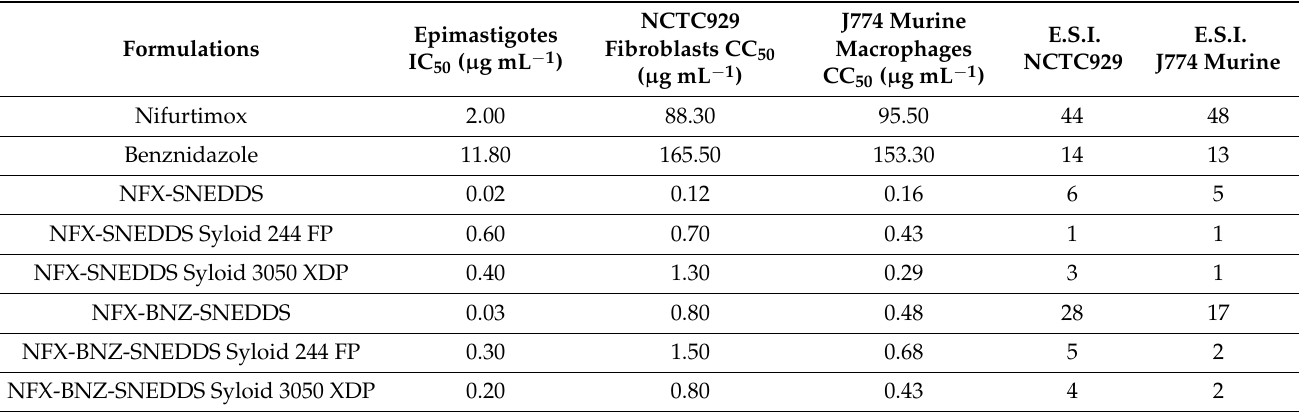
Figure 7. Shelf-life prediction in years of formulations under refrigerated conditions. NFX-SNEDDS ( A ), NFX-SNEDDS impregnated on Syloid 244 FP (2:1 w / w ) ( B ), NFX-SNEDDS impregnated on Syloid 3050 XDP (2:1 w / w ) ( C ), NFX -BNZ SNEDDS ( D ), NFX -BNZ-SNEDDS impregnated on Syloid 244 FP (2:1 w / w ) ( E ), NFX -BNZ-SNEDDS impregnated on Syloid 3050 XDP (2:1 w / w ) ( F ), NFX- BNZ - SNEDDS ( G ), NFX- BNZ -SNEDDS impregnated on Syloid 244 FP (2:1 w / w ) ( H ), NFX- BNZ -SNEDDS impregnated on Syloid 3050 XDP (2:1 w / w ) ( I ). Key: Drug highlighted in bold indicates the drug of the combined NFX-BNZ SNEDDS that the stability data are shown. Yellow line indicates the specification limit (90%). For all graphs, Y -axis spans between 70–110% with labels every 5% and X -axis spans between 0–3 years with labels every 0.25 years. Table 6. Trypanocidal activity of NFX and BNZ formulations on extracellular T. cruzi forms and cytotoxicity on fibroblast and macrophages cell